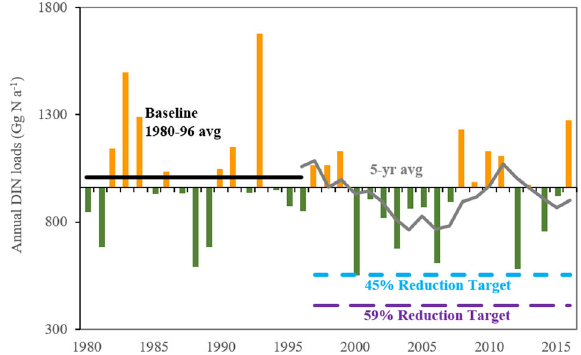
Fig. 1 Large inter-annual variations can be found in the monitored dissolved inorganic nitrogen (DIN) loads from the Mississippi and Atchafalaya river basin (MARB) to the Gulf of Mexico during 1980 – 2017. X -axis crosses y -axis at the 38-year average (961 Gg N year − 1 ). Annual values were calculated as the sum of N loading measured at the St. Francisville, LA (Station ID 07373420) and Melville, LA (station